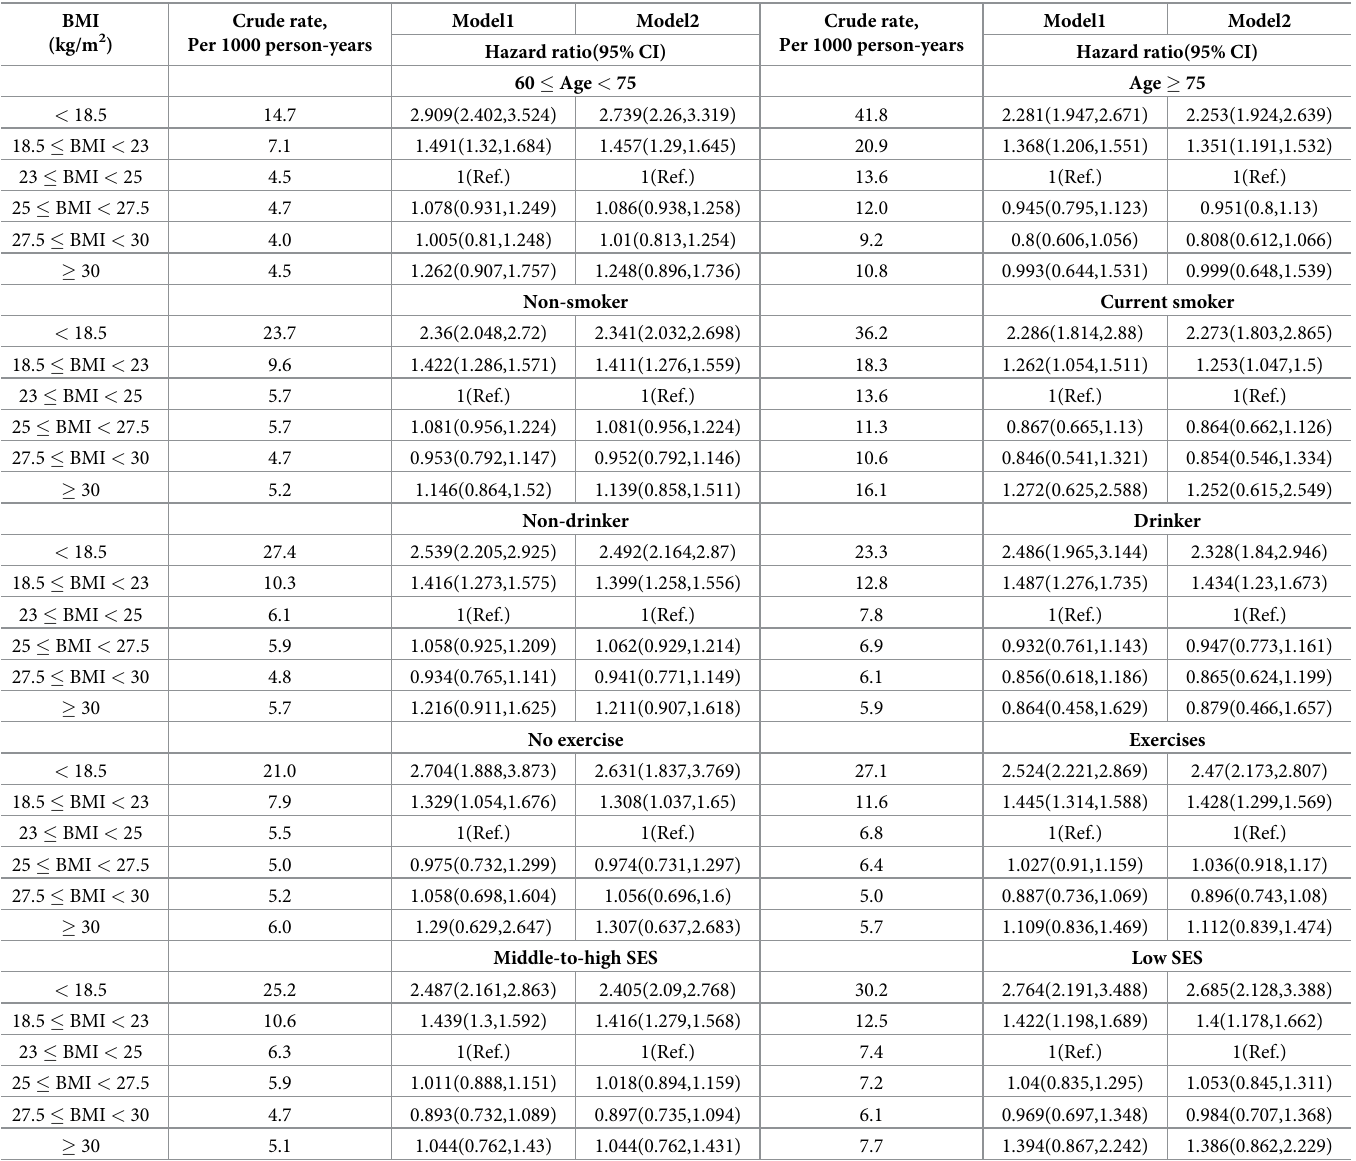
Table 3. Subgroup analysis association between body mass index and all-cause